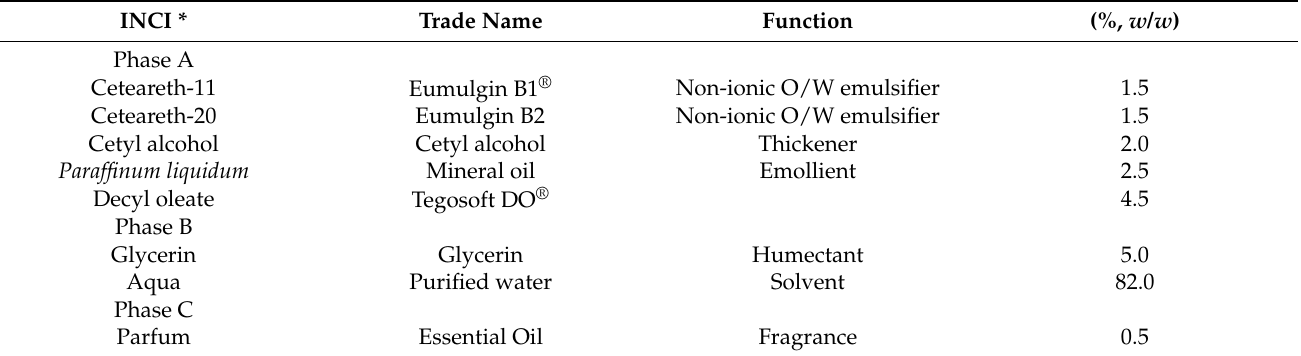
Table 11. Qualitative and quantitative (%, w / w ) composition of the emulsions prepared with Eucalyp- tus globulus , Pinus pinaster , Pinus pinea and Cryptomeria japonica essential oils.